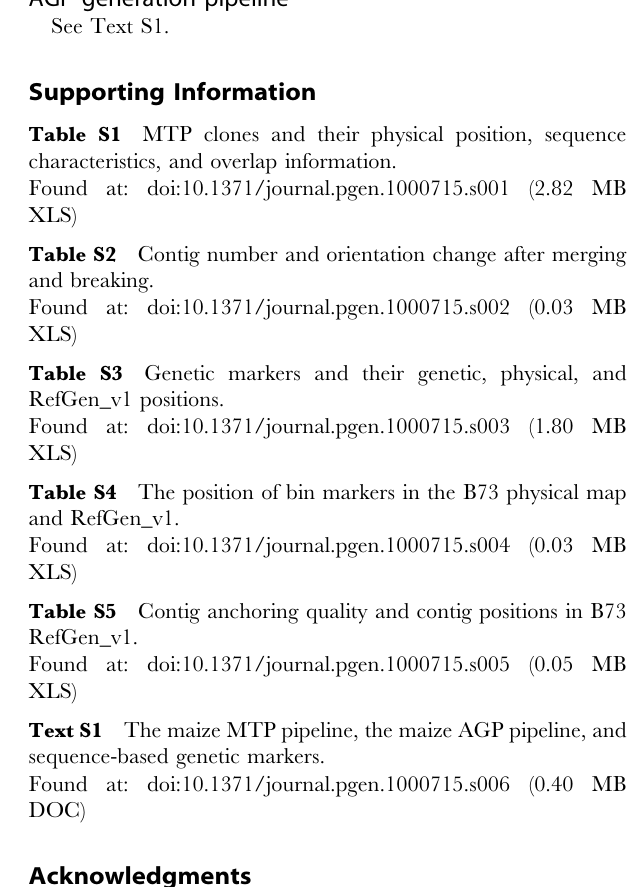
Table S1 MTP clones and their physical position, sequence characteristics, and overlap information.